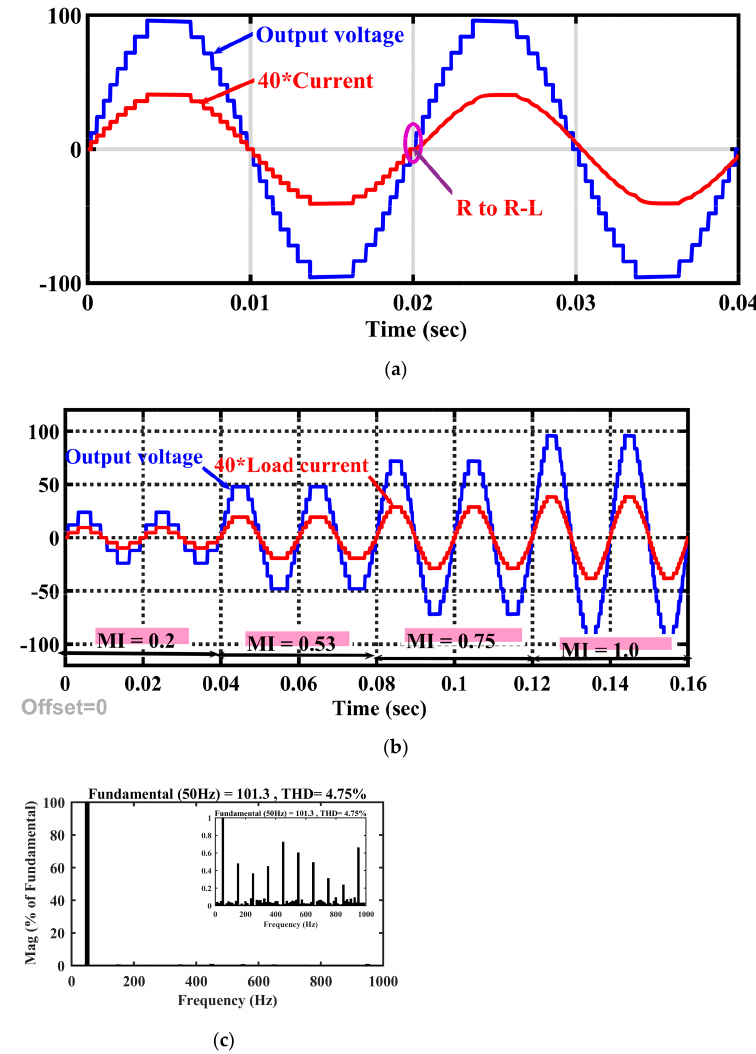
Figure 12. ( a ) Output voltage and current for change in load from resistive to resistive-inductive, ( b ) output voltage and current for dynamic change in modulation index, and ( c ) THD in output voltage for asymmetric configuration.